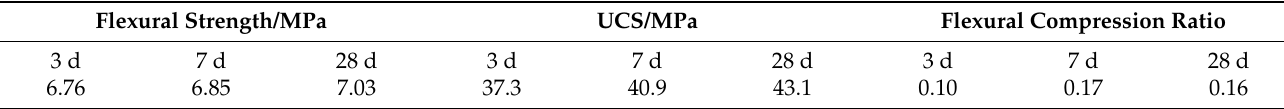
Table 3. Mechanical properties of SL